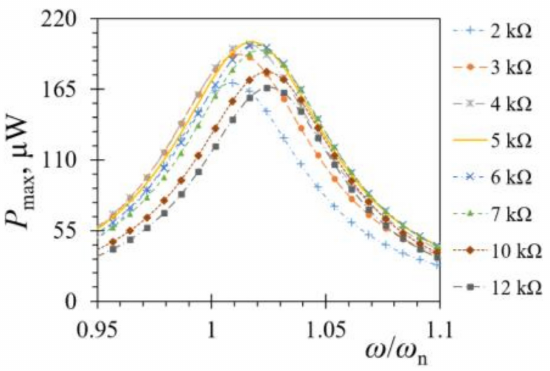
Figure 14. FE obtained powers at various load resistance